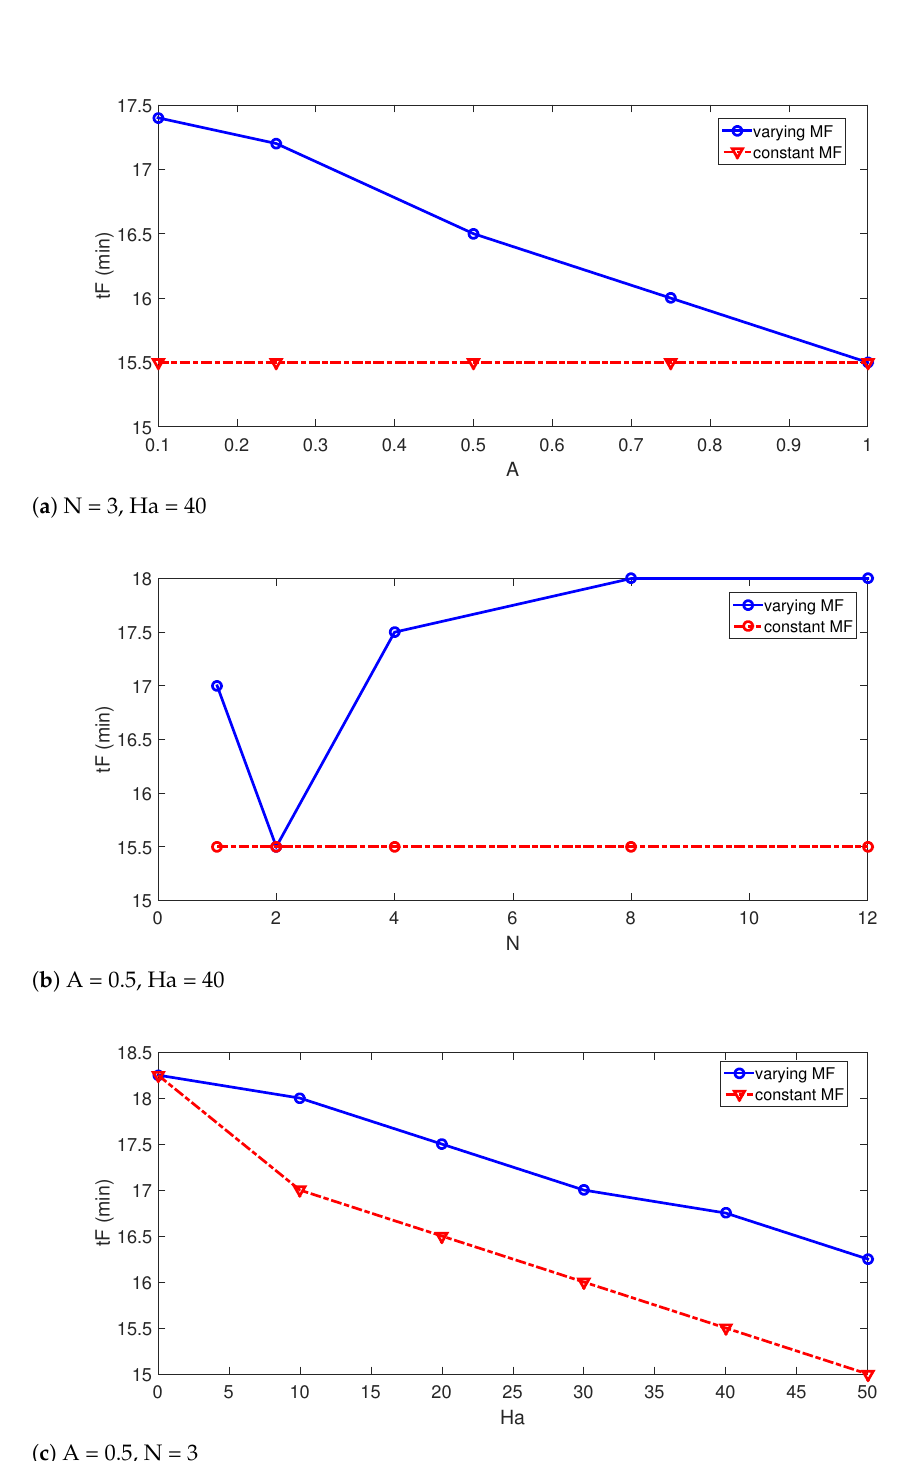
Figure 11. Impacts of varying MF amplitude ( a ), wave number ( b ) and MF strength ( c ) on the variation of the complete phase transition time ( K = 1.25, M = 0.5, φ =